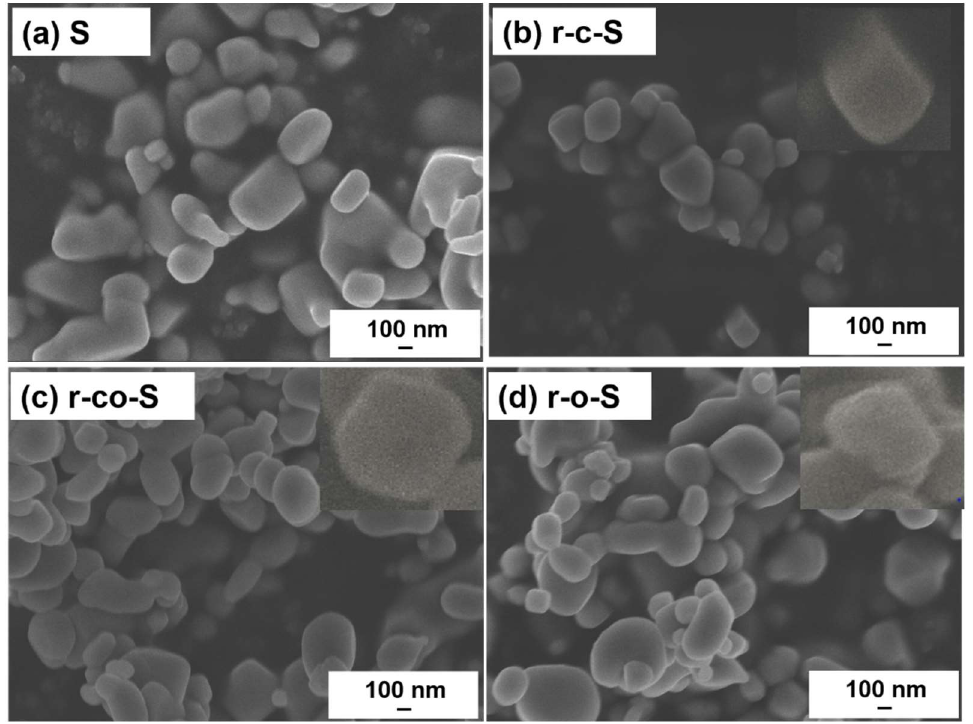
Figure 4. SEM images of titania and FCP-loaded titania. Enlarged SEM images are inserted.